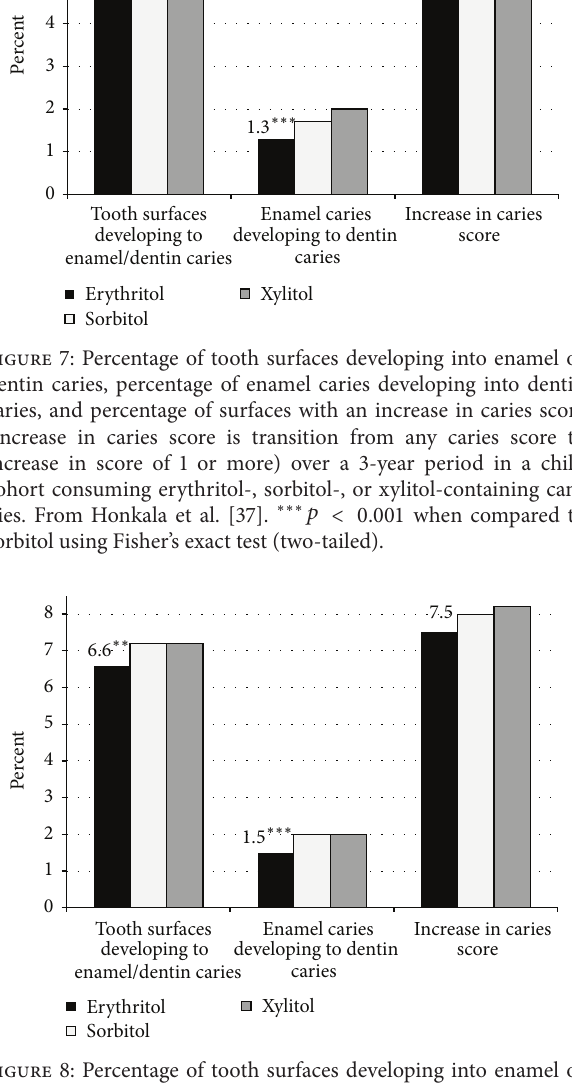
Figure 8: Percentage of tooth surfaces developing into enamel or dentin caries, percentage of enamel caries developing into dentin caries, and percentage of surfaces with an increase in caries score (increase in caries score is transition from any caries score to increase in score of 1 or more) in a child cohort consuming erythritol-, sorbitol-, or xylitol-containing candies 3 years after intervention. From Falony et al. (manuscript submitted). ∗∗ 𝑝 < 0.05 when compared to sorbitol using Fisher’s exact test (two-tailed). ∗∗∗ 𝑝 < 0.001 when compared to sorbitol using Fisher’s exact test